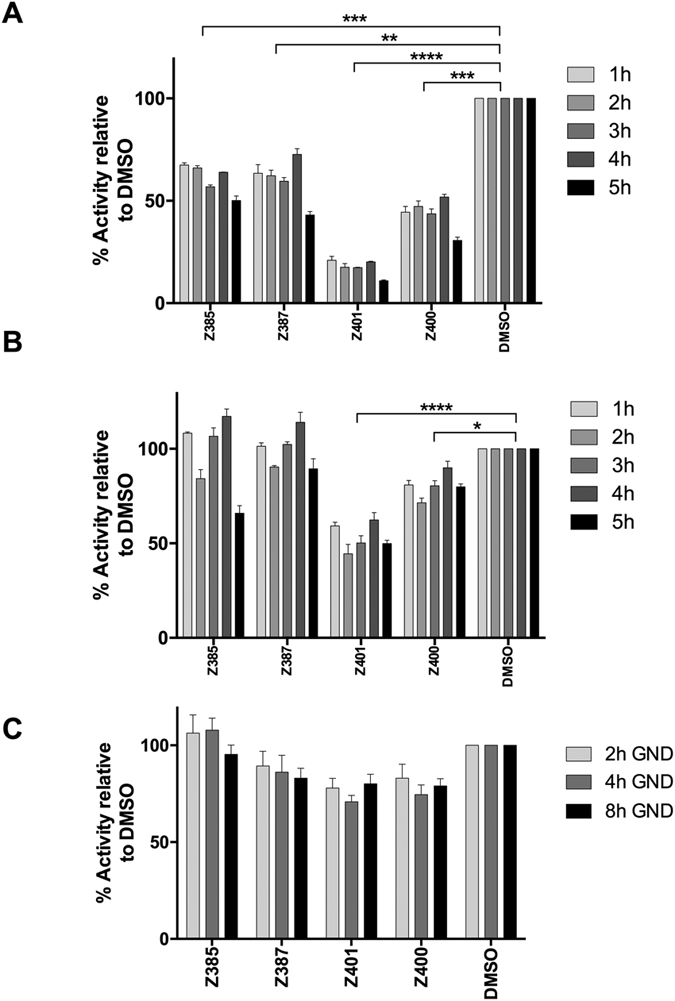
Inhibition at early stage of viral replication.(A) Huh7 cells were electroporated with SGR-JFH-luc RNA and seeded in the presence of the drugs for 1 to 5 h. Then, drugs were removed, replaced with fresh medium and incubated for 24. One-way ANOVA Test (**p < 0.01; ***p < 0.001; ****p < 0.0001). (B) Huh7 cells were treated as described for A but incubated for 48 h. One-way ANOVA Test (*p < 0.05; ****p < 0.0001). (C) Possible effect on viral translation. Cells were electroporated with SGR-JFH-GND-luc and seeded in the presence of drugs. Luciferase was analysed 2, 4 and 8 h post transfection.